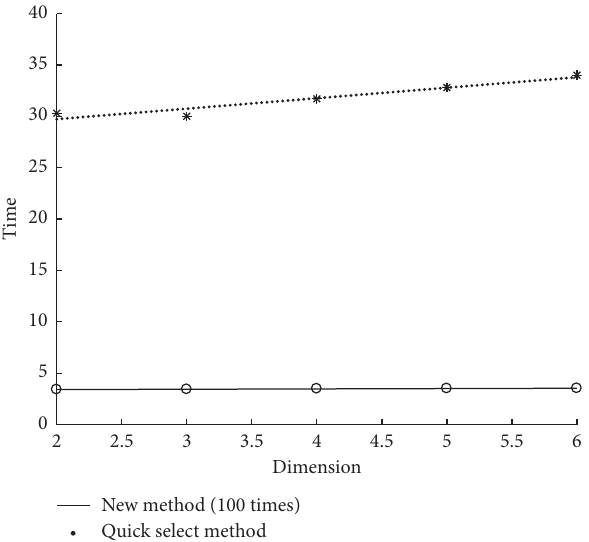
Figure 6: Construction time (seconds) for 2 17 real elements (the elements are arranged from large to small in each dimension) in different dimensions. The execution time based on the new method is magnified by 100 times.